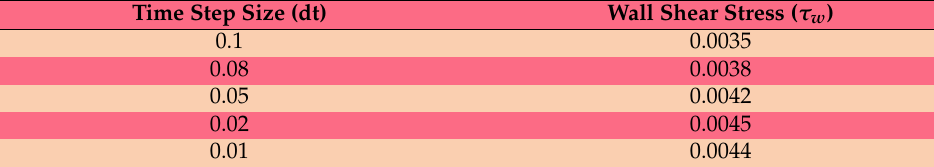
Table 4. Time Independence.